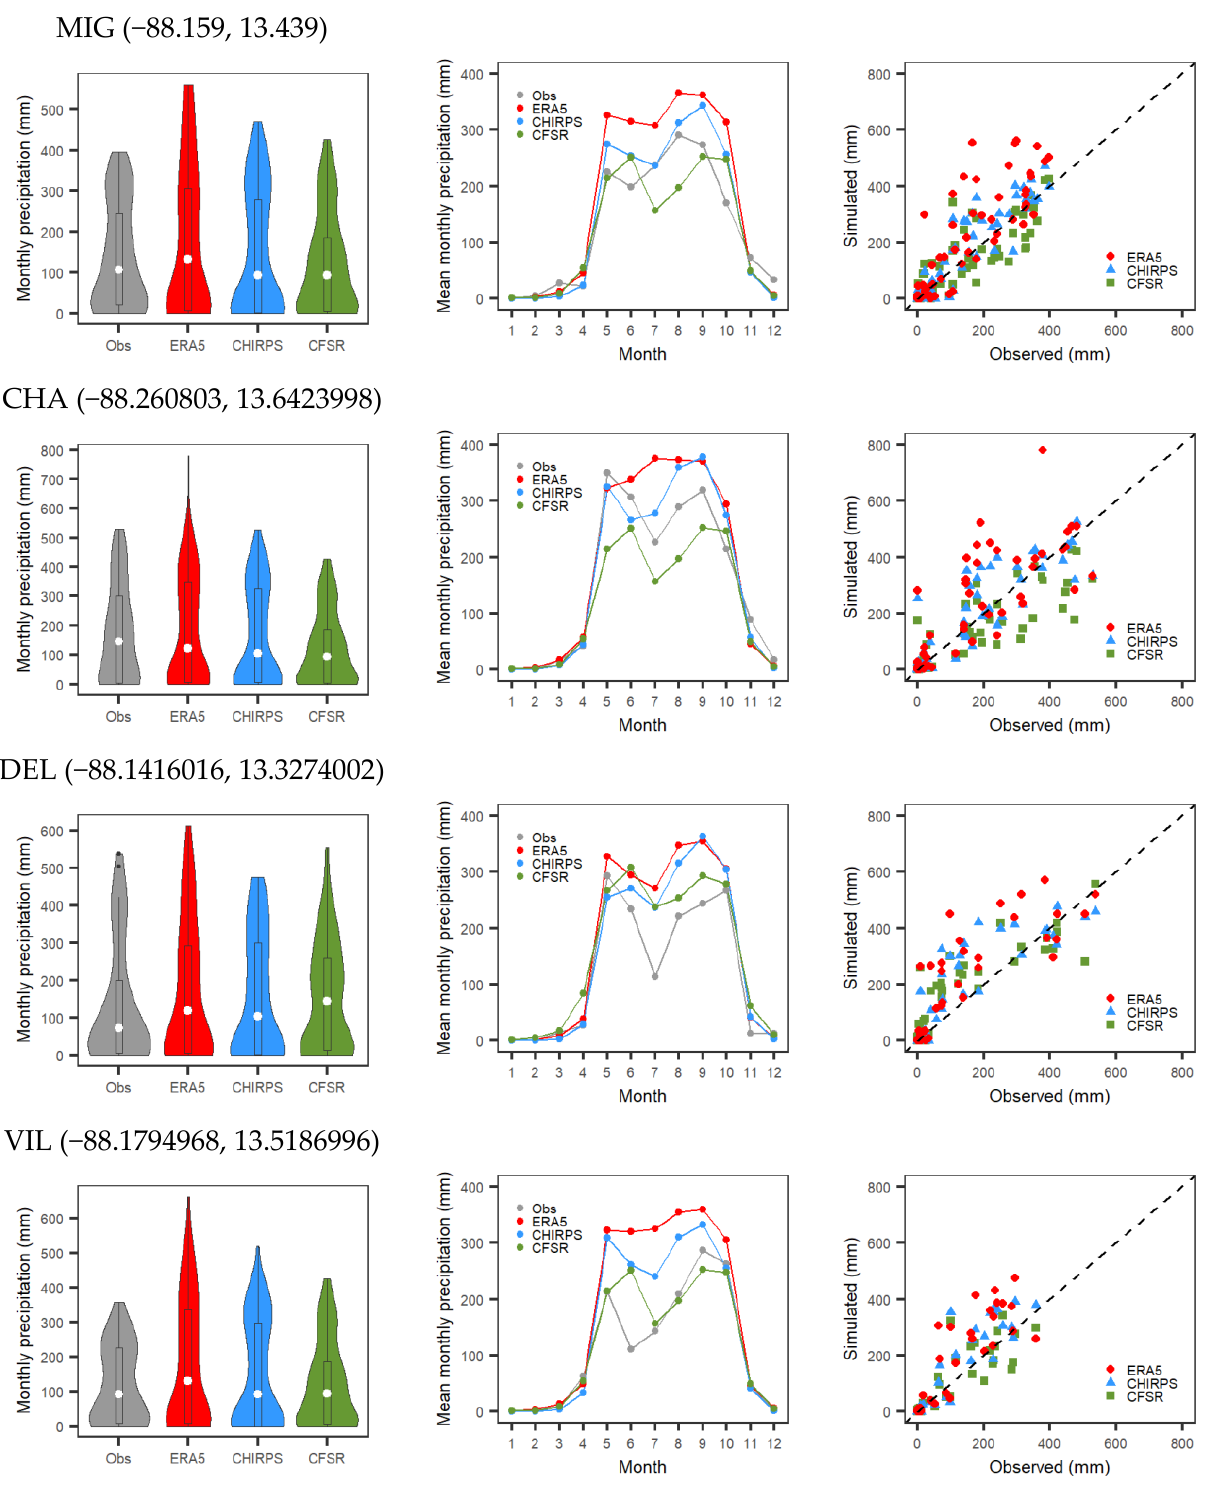
Figure 4. Comparison of average monthly observed precipitation with ERA5, CHIRTS, and CFSR datasets using violin plots ( left column), variations in rainfall patterns ( central column) and scatterplots ( right column).